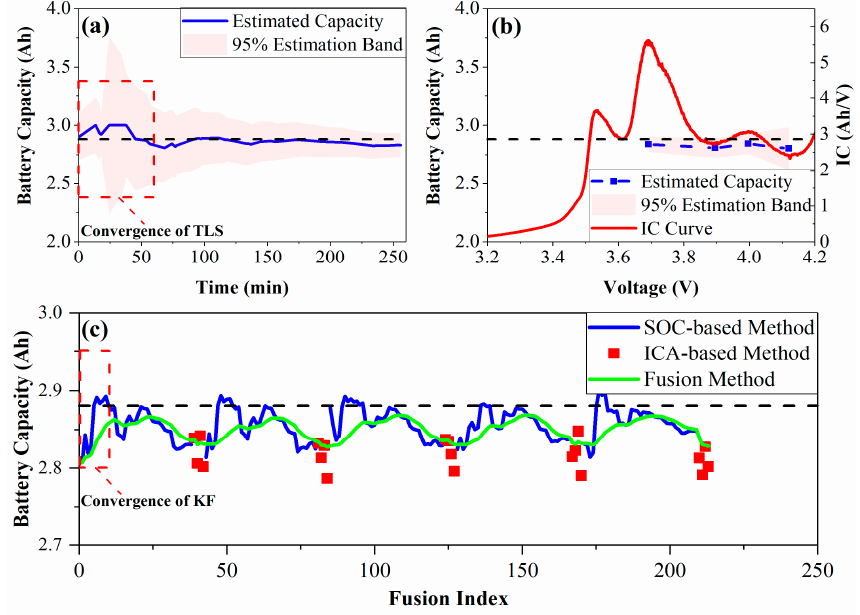
Figure 5. The capacity estimation and fusion results of Cell 1. ( a ) The estimated capacity and uncertainty from SOC-based method during DDC 1. ( b ) The estimated capacity and uncertainty from ICA-based method during CCCV 1. ( c ) The fusion results during 5 complete cycles.